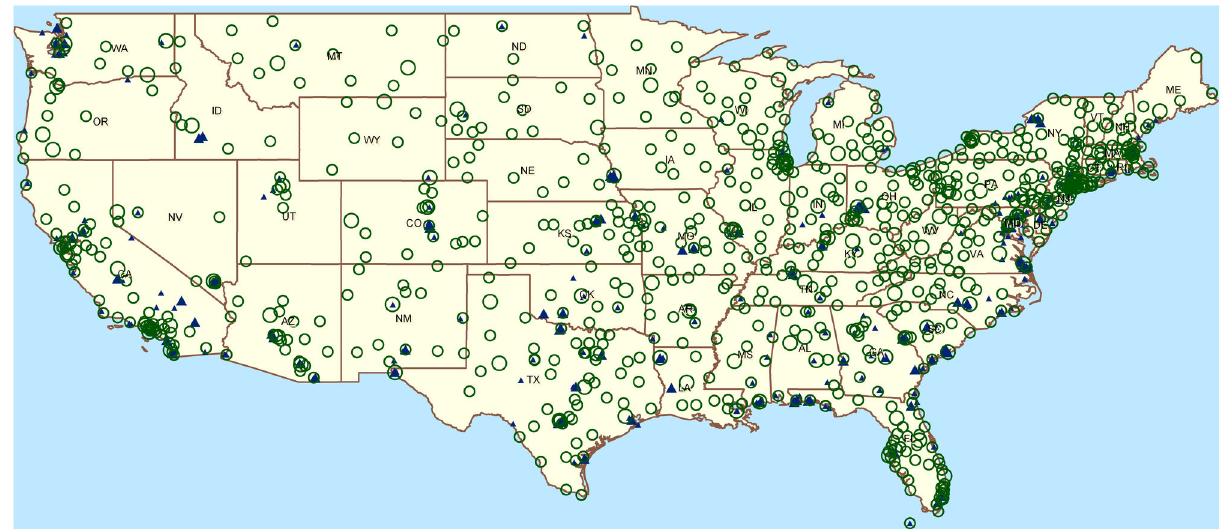
Figure 1. Department of Defense and Veterans Affairs medical facilities in the continental United States. Locations of VA hospitals (large green circles) and clinics (small green circles) and DoD hospitals (large blue triangles) and clinics (small blue triangles) in the continental US.